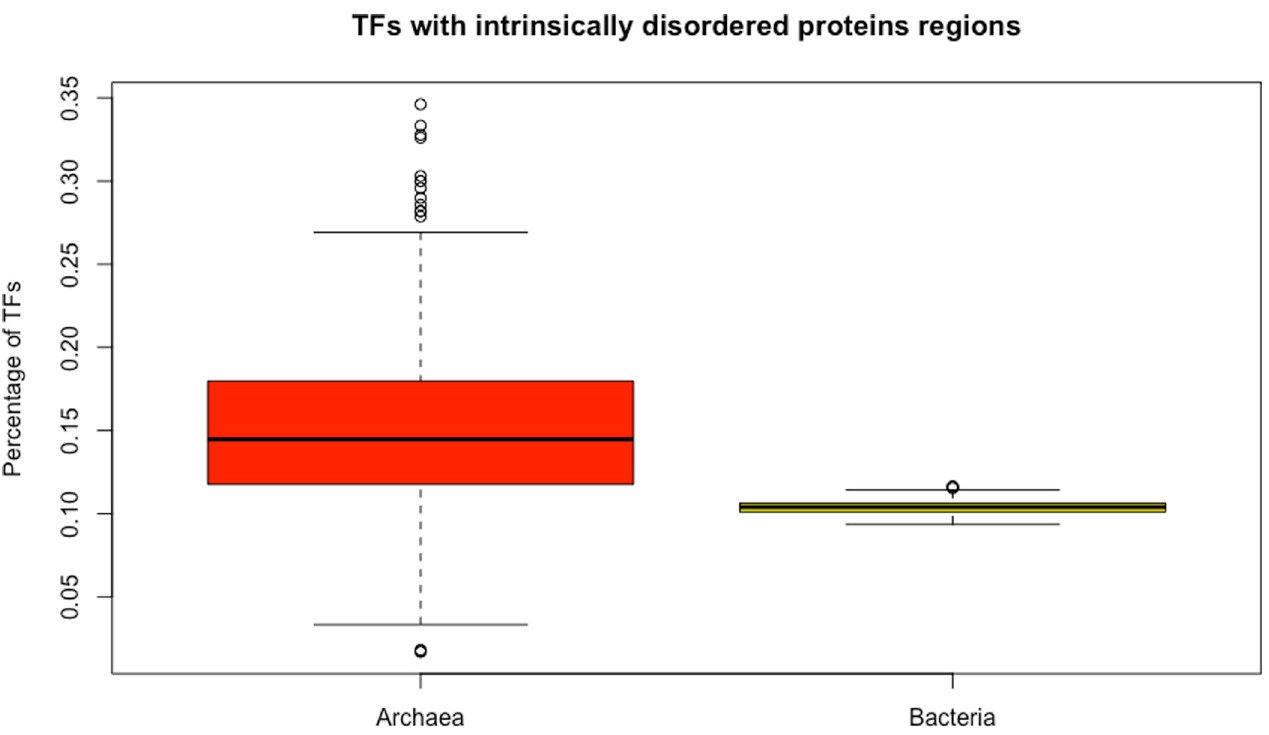
Fig 7. Proportion of TFs with disorder regions in archaea and the normalized values in representative bacterial dataset. The distributions are different from each other (Wilcoxon test, p-value < 2.2e-16).